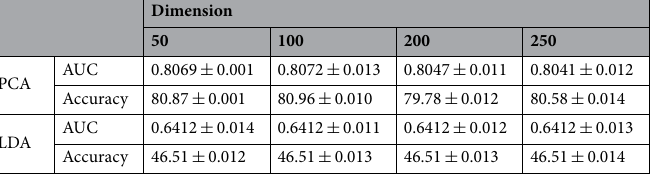
Table 3. The performance of newly labelled data using LDA and PCA feature extraction